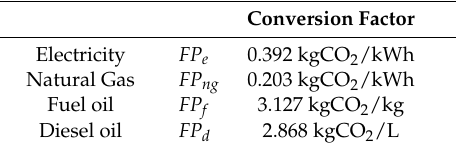
Table 26. Conventional energy sources conversion factors.